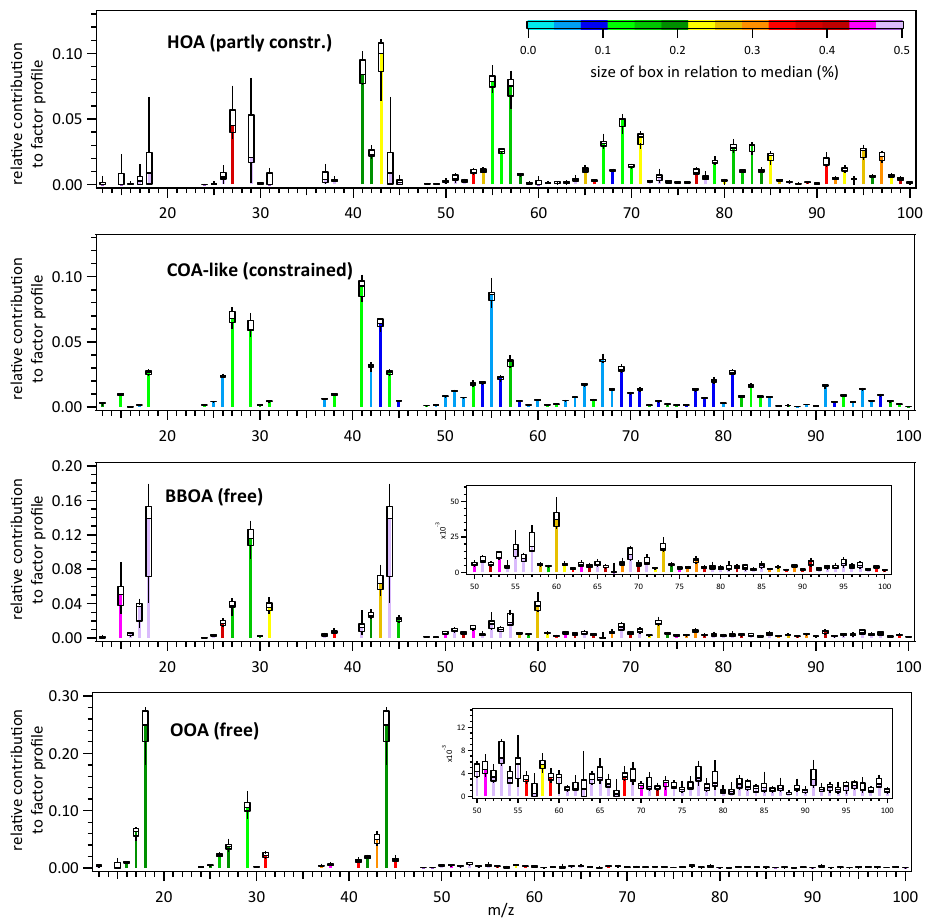
Figure 6. Median source factor profiles of the 13 Q-ACSMs (sticks) sorted from top to bottom as follows: HOA, COA-like, BBOA, OOA. The boxes represent the IQR for each m/z stick and the whiskers represent the corresponding full range over all instruments. The line in the box indicates the median. The colour bar represents the ratio of the width of the individual boxes in relation to the corresponding median in percent. The region between m/z 50 and 100 is enlarged in the two small insets for the BBOA and the OOA